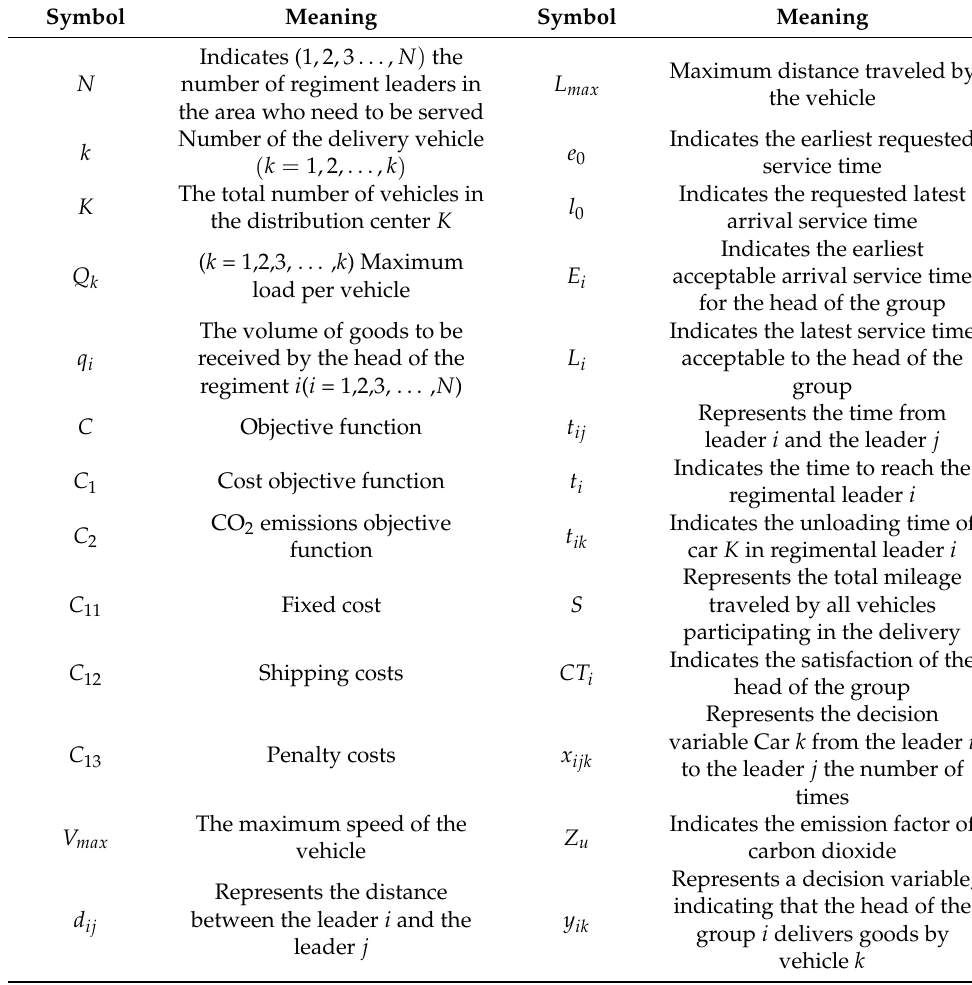
Table 1. Mathematical model variable symbols and